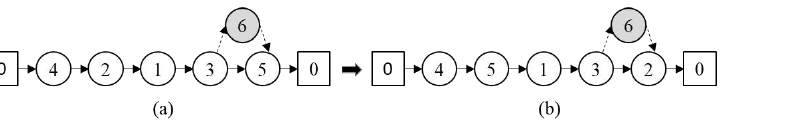
Figure 5. Example of the Swap move: ( a ) displays the TSP-D solution, tspd , before applying Swap ; and ( b ) displays the tspd after nodes 2 and 5 have been swapped.